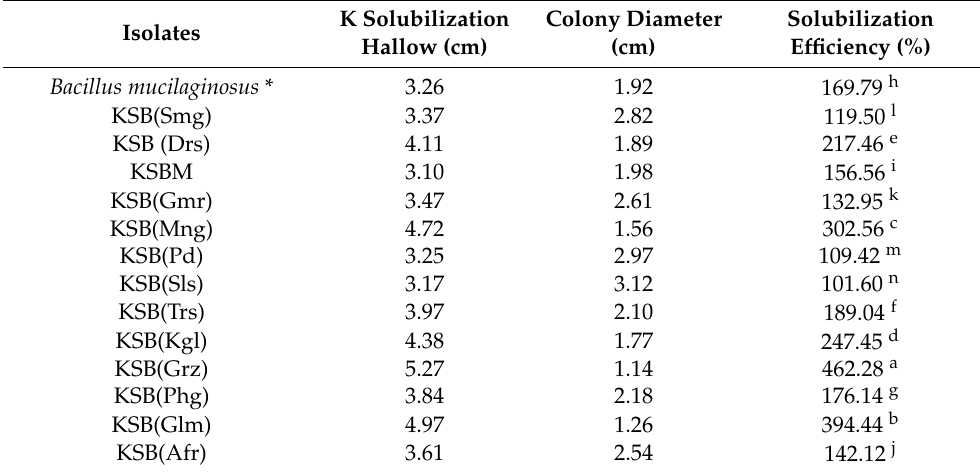
Table 1. K solubilization efficiency of cold-tolerant bacterial isolates at 20 ◦ C after 48 h.